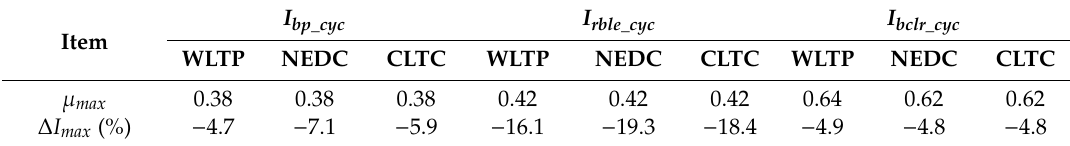
Table 5. Results of